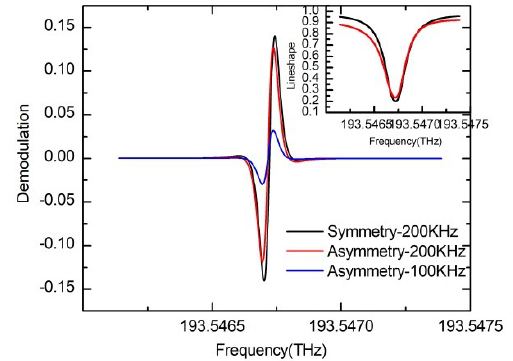
Figure 4. The asymmetry resonance curves and demodulation curve with different modulation frequencies.